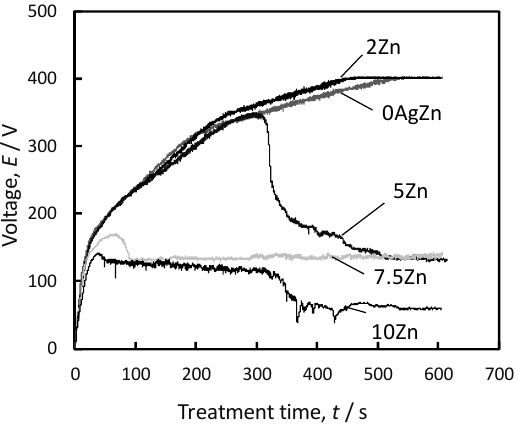
Figure 1. Voltage changes during MAO treatment with different ZnCl 2 concentrations.